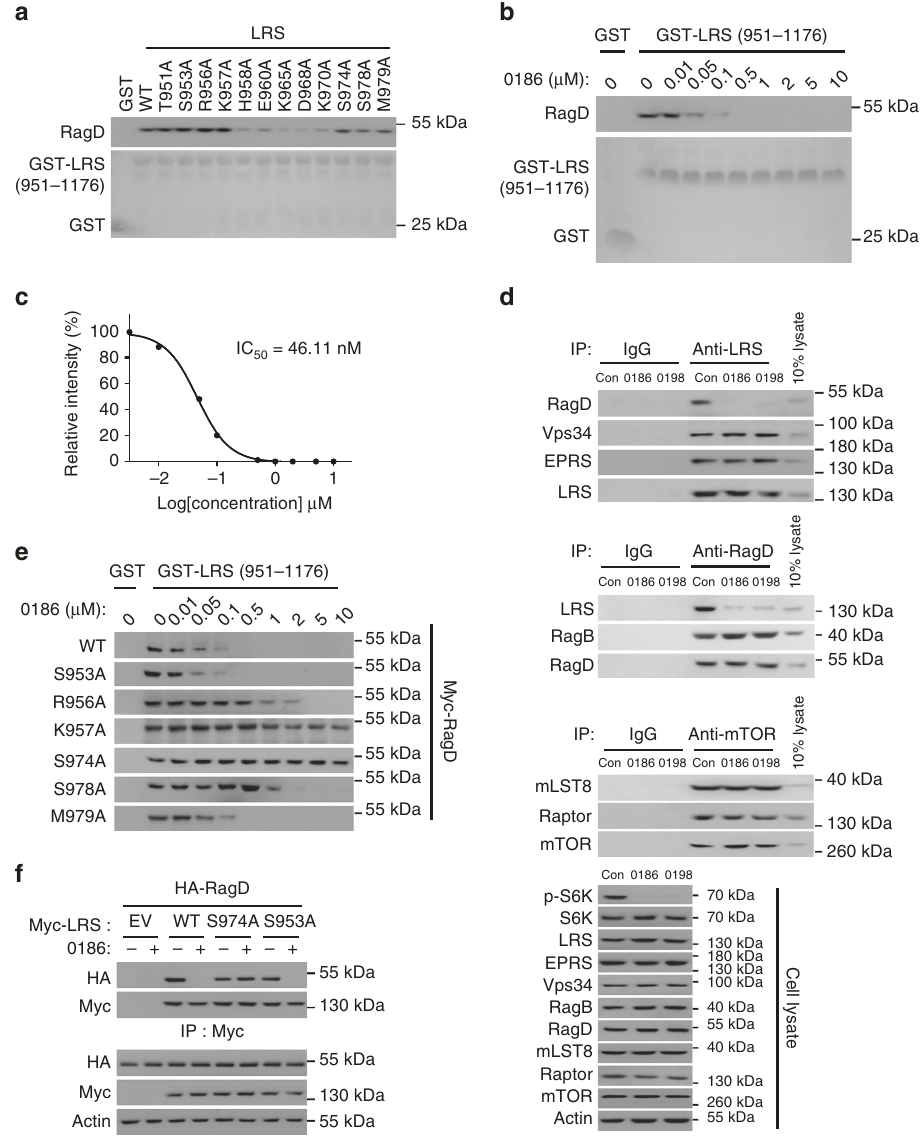
Fig. 3 Chemical inhibition of the LRS – RagD interaction. a Effect of alanine mutations at the indicated residues located in the aa 951 – 981 peptide region of LRS VC domain on the interaction of LRS and RagD was determined by GST pull-down assays. Puri fi ed GST or GST-LRS (aa 951 – 1176) proteins were incubated with Myc-RagD WT -transfected SW620 cell lysates, precipitated with glutathione sepharose beads and the precipitation of Myc-RagD was analyzed by immunoblotting with anti-Myc antibody. b Effect of BC-LI-0186 on the interaction of LRS WT with RagD was determined by in vitro pull-down of GST-LRS (957 – 1176 aa) and Myc-RagD. c Relative band intensity of Myc-RagD in b was quanti fi ed and displayed as line graph . The inset represents the IC 50 value of BC-LI-0186. d Effect of BC-LI-0186 and BC-LI-0198 on the endogenous interaction of LRS with RagD. Cells were treated with 10 μ M BC-LI- 0186 for 1 h and cell lysates were subjected to immunoprecipitation with anti-LRS, anti-RagD, or anti-mTOR antibodies. Co-immunoprecipitation was con fi rmed by immunoblotting with the indicated antibodies. e Effect of BC-LI-0186 on the interaction of LRS WT and the indicated mutants with Myc-RagD was determined by co-immunoprecipitation. f SW620 cells were co-transfected with Myc-tagged LRS WT, S974A, or S953A mutant and HA-tagged RagD WT. Cells were treated with 10 μ M BC-LI-0186 for 1 h and cell lysates were subjected to immunoprecipitation with anti-Myc antibody. Cellular levels of the indicated proteins were analyzed by immunoblotting with their speci fi c antibodies NATURE COMMUNICATIONS | 8: